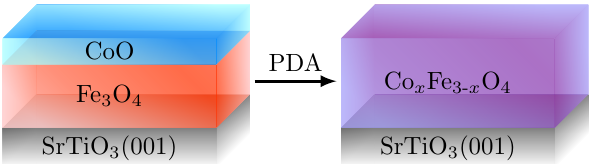
Figure 1. Principal sketch of the conducted film preparation. The thermally induced interdiffusion results in the formation of homogeneous Co x Fe 3 − x O 4 films from initial epitaxial CoO/Fe 3 O 4 bilayers grown on Nb-doped SrTiO 3